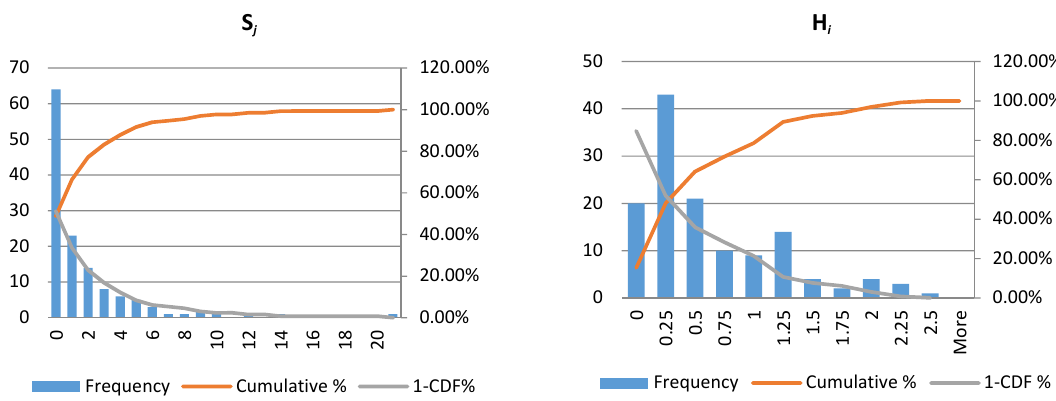
Int. J. Financial Stud. 2016 , 4 , 13 Figure 5. Histogram, cumulative distribution and complement of cumulative distribution of s j and H i .